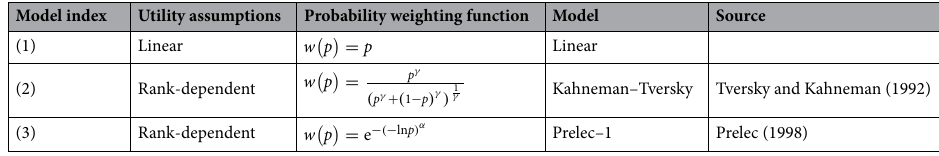
Table 2. Stochastic choice model specifications used for parameter estimation. Parameters γ and α correspond to the curvature (degree of distortion) of the probability weighting